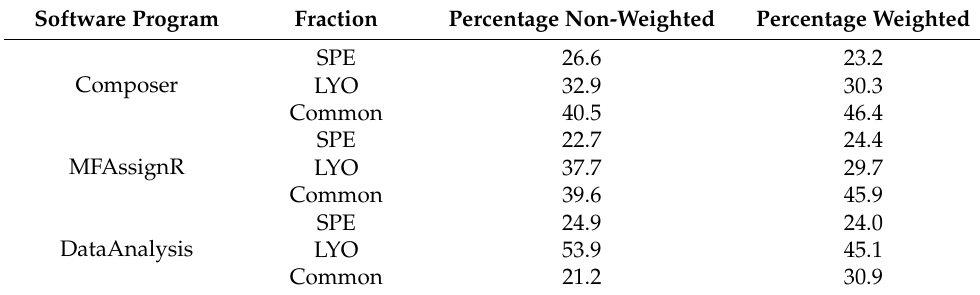
Table 1. Weighted and non-weighted percentages obtained for the comparison of SPE and LYO; “SPE” means MFs found only in the SPE data treatment, “LYO” means MFs found only in the LYO data treatment, while “Common” refers to MFs found in both data treatment groups.